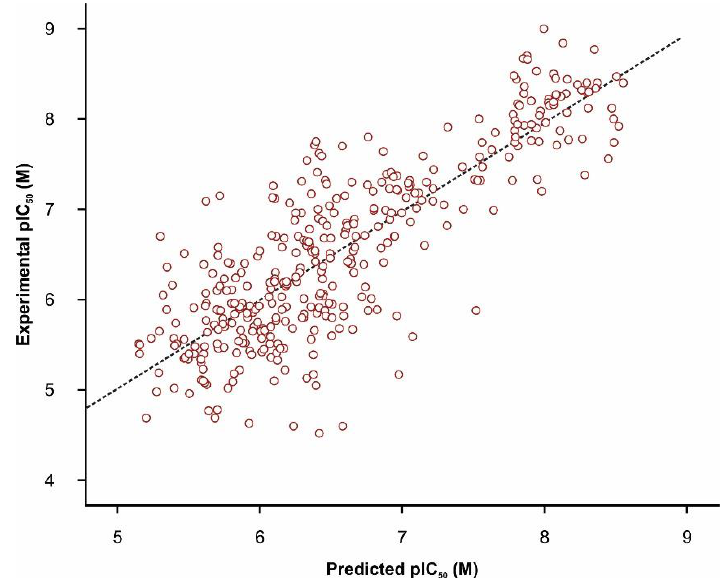
Figure 5. Correlation plot between experimental and MLR predicted activity values (pIC 50 pred ) of the TRPA1 inhibitor dataset (R 2 pred = TRPA1 inhibitor dataset (R 2 pred = 0.700).